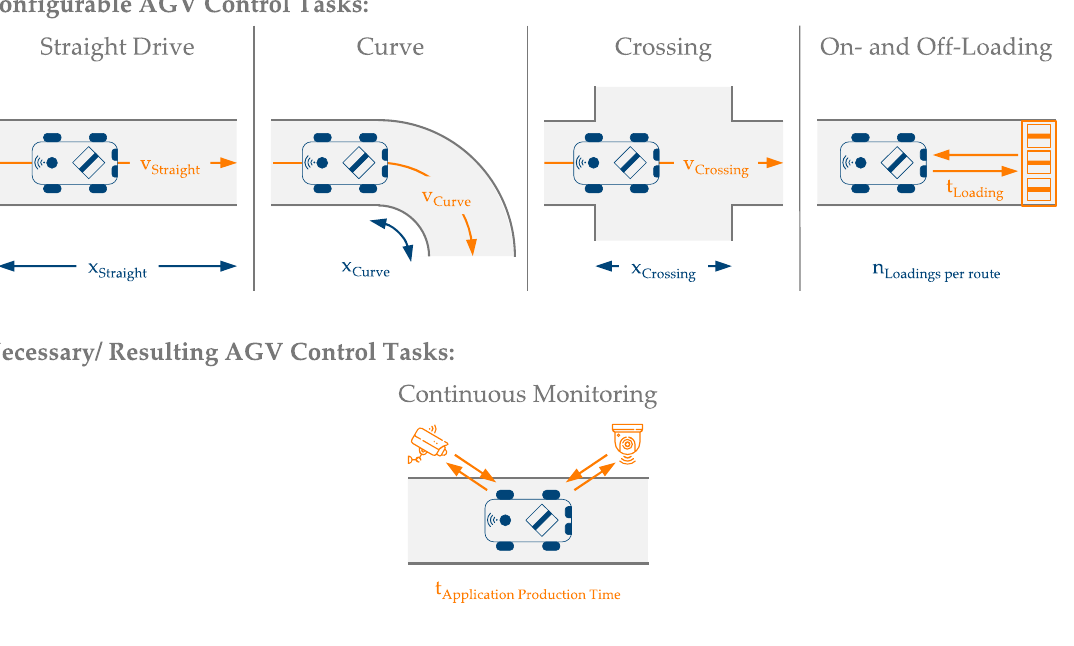
Figure 7. 5G-improved and enabled control tasks.